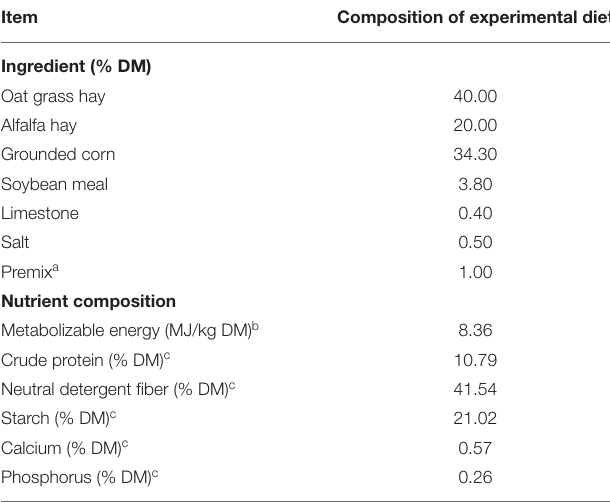
TABLE 1 | Ingredients and nutritional composition of basal experimental diet offered to rumen fluid donor